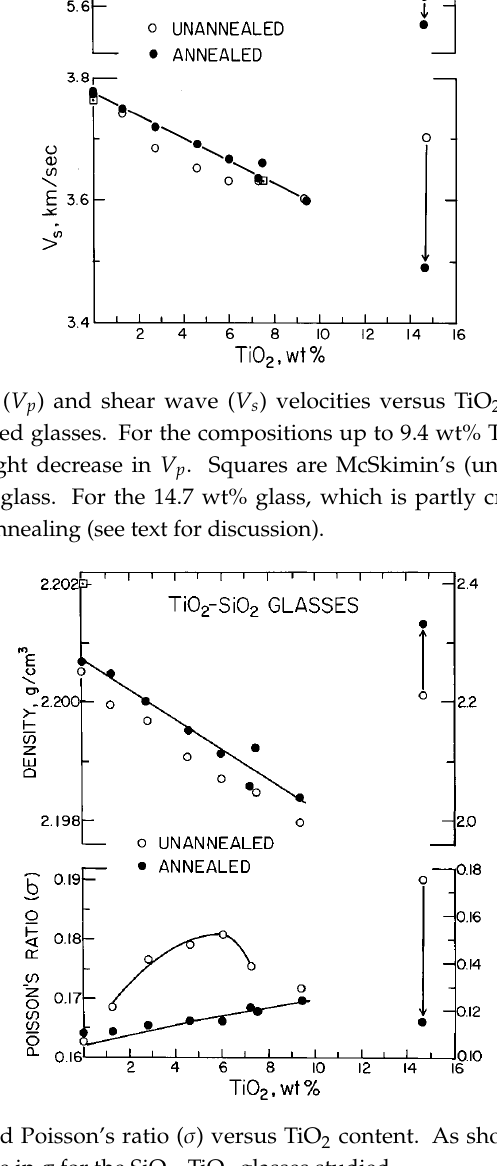
Figure 3. Bulk ( K ), shear ( μ ) and Young’s ( E ) moduli versus TiO 2 content. Annealing causes an increase in K , and a decrease in μ and E . Squares are McSkimin’s (unpublished) 1972 data. Error bars are smaller than the symbols.